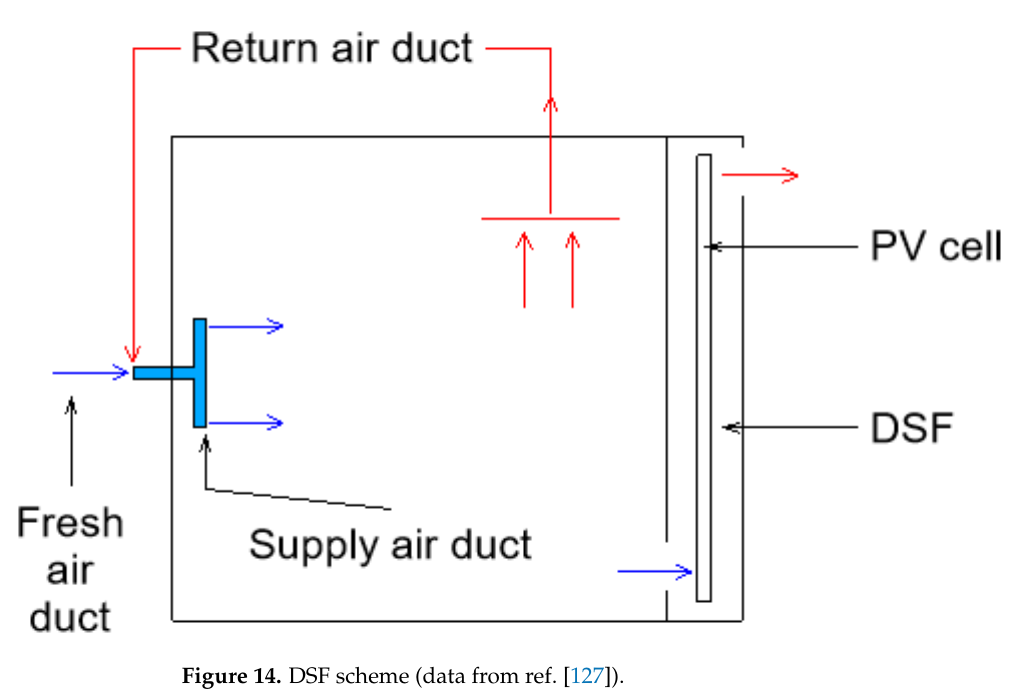
Figure 14. DSF scheme (data from ref. [127]) .